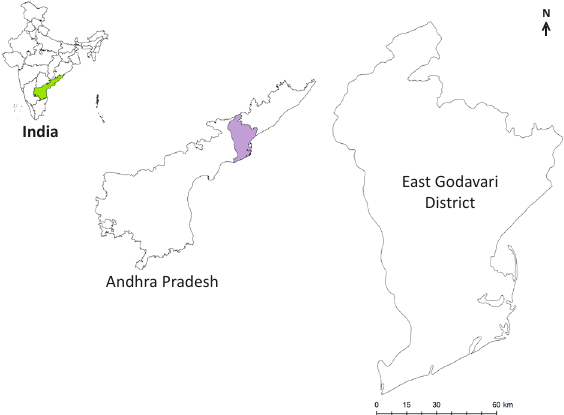
Figure 1. Map of study